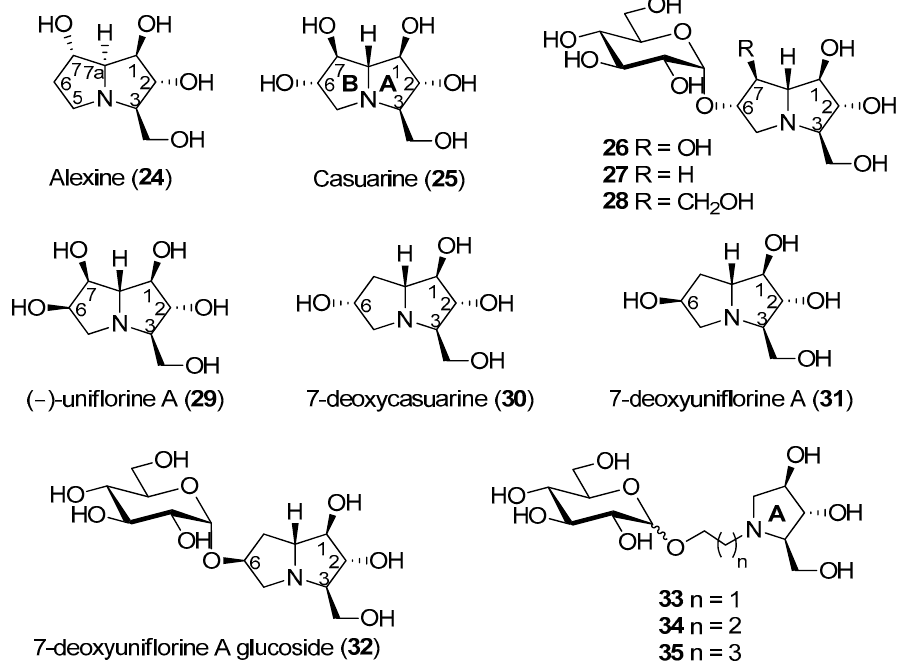
Figure 5. Structures of bicyclic or glycosylated iminosugar-based trehalase inhibitors.